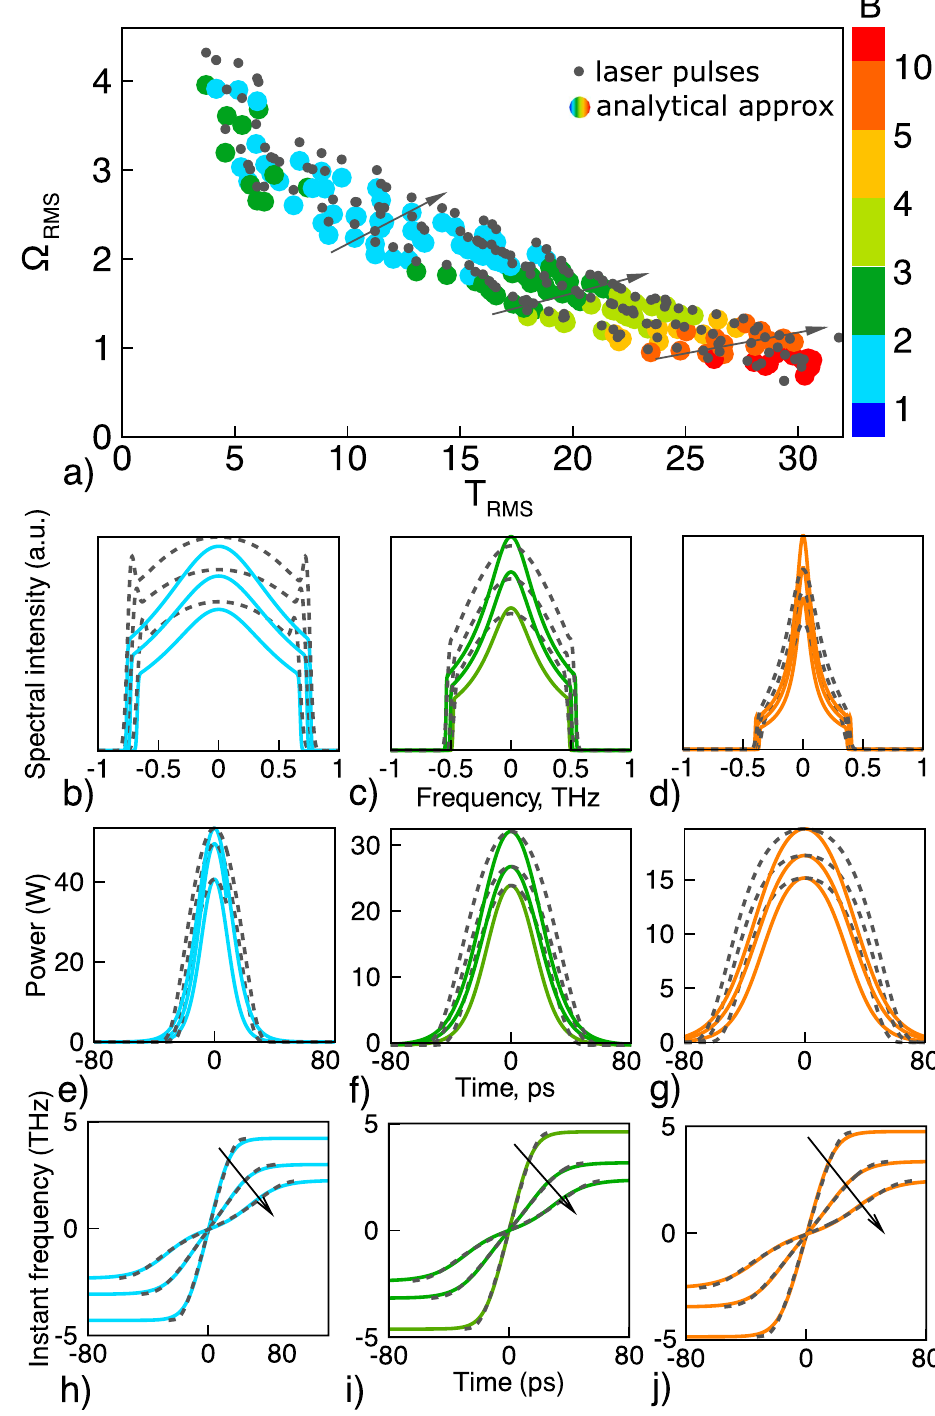
Figure 4. ( a ) RMS temporal and spectral width of the laser pulses and their analytical approximation (3). Color shows the value of parameter B. ( b – j ) Comparison of the pulse shapes of the laser pulses (dashed lines) and their analytical